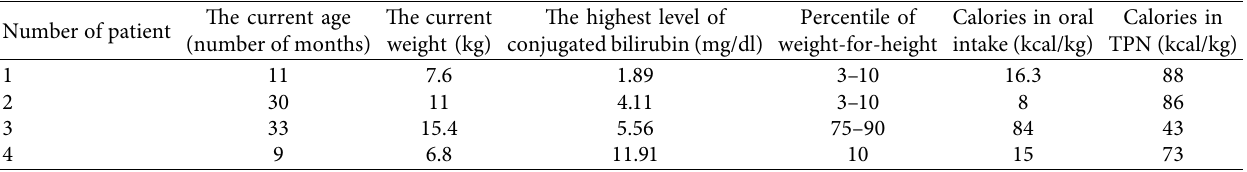
Table 1: Characteristics of the patients.